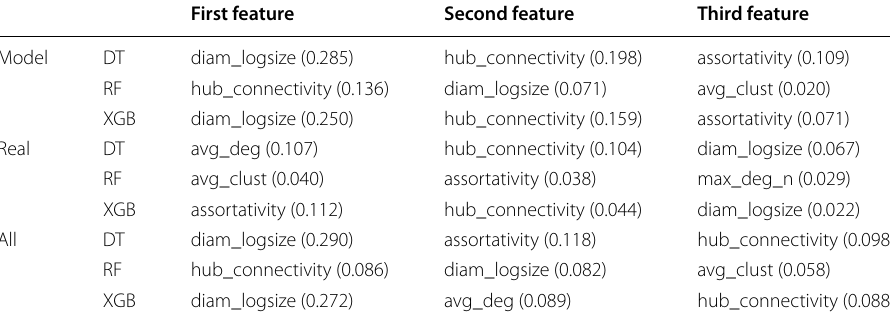
Table 7 The most important features for every algorithm and dataset. For all the cases the three features with the highest permutation importance score are listed, showing the exact scores as